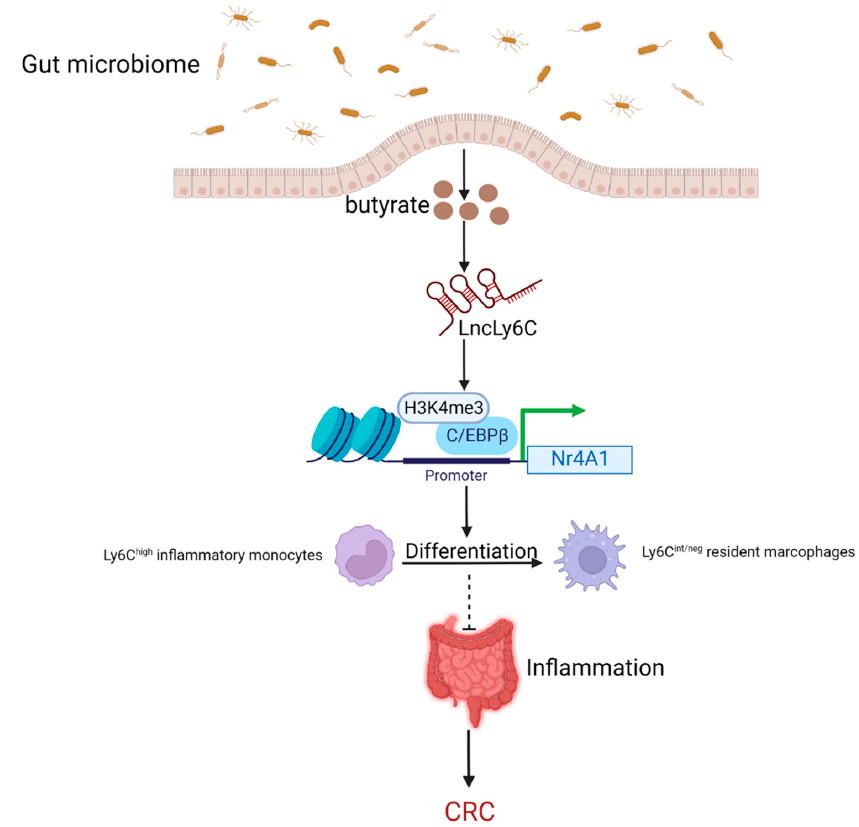
Figure 4. Butyrate as the metabolite of the gut microbiome inhibits the intestinal inflammation to lower the risk of CRC by regulating lncRNA LncLy6C. Butyrate-induced LncLy6C binds to the